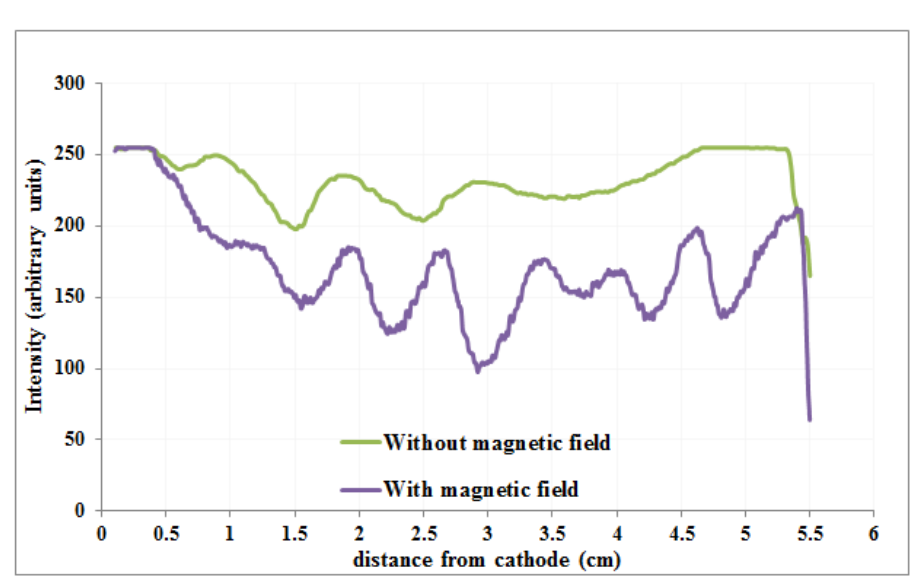
Fig. 8: Influence of magnetic field on the glow distribution between electrodes at Pressure of 0.27 mbar.